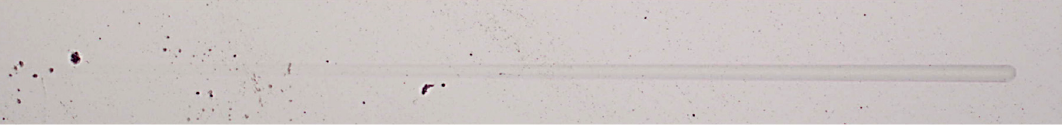
Figure 23. Scratch after testing of the SH-15-TiBN sample .